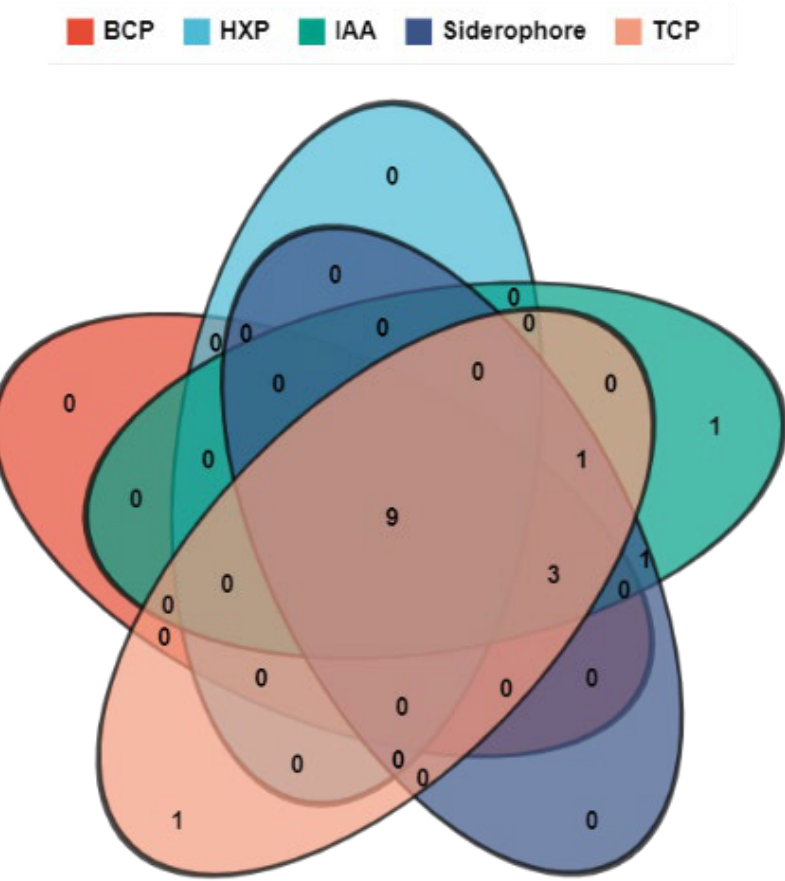
Figure 4. Venn diagram of PGP mechanisms detected in the selected strains. BCP: bicalcium phos- phate; TCP: tricalcium phosphate; HXP: hydroxyapatite; IAA: indole-3-acetic acid.